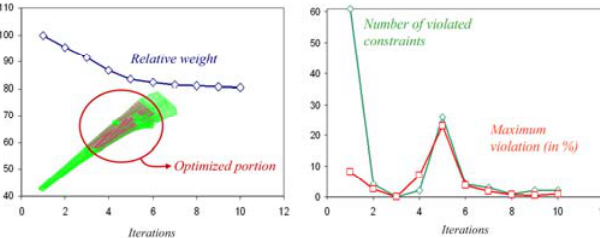
Fig. 11. Convergence history for the optimization of the composite